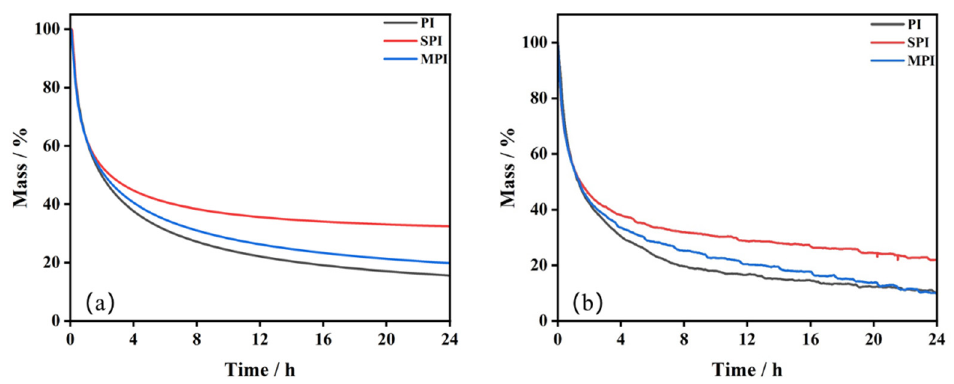
◦ C for 24 h: ( a ) prediction; ( b ) Figure 8. Mass loss of the three substances at 500 °C for 24 h: ( a ) prediction; ( b ) experiment . Figure 8. Mass loss of the three substances at 500